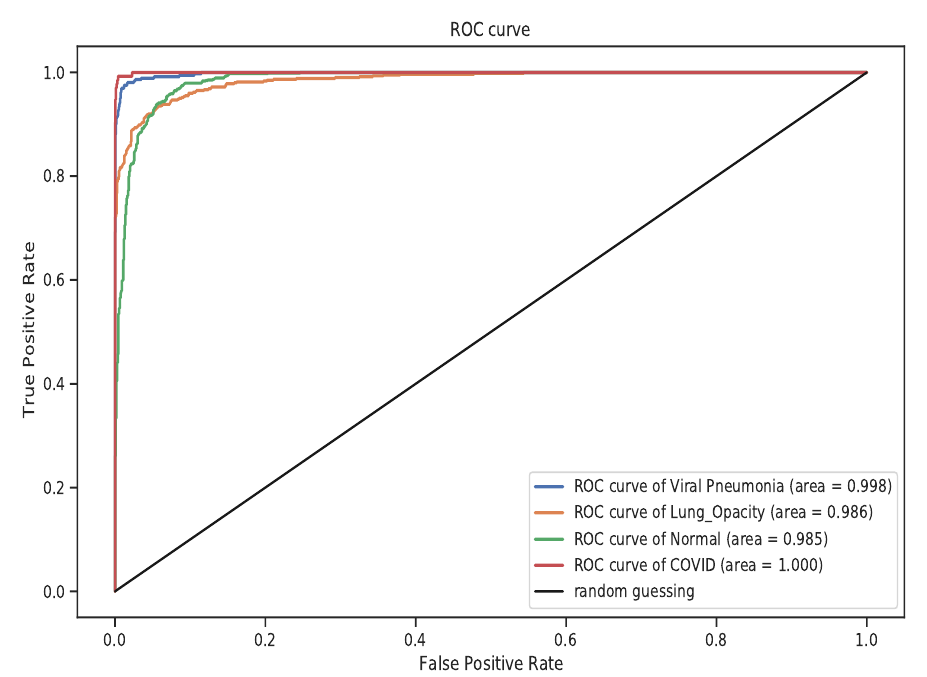
Figure 16. The ROC curve. COVID-19 achieved the highest AUC of 1.0 followed by Viral Pneumonia class having 0.998 whilst the two remaining classes have AUC of